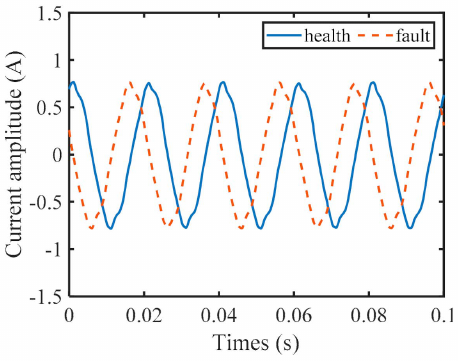
Figure 15. Time domain signal of stator current.